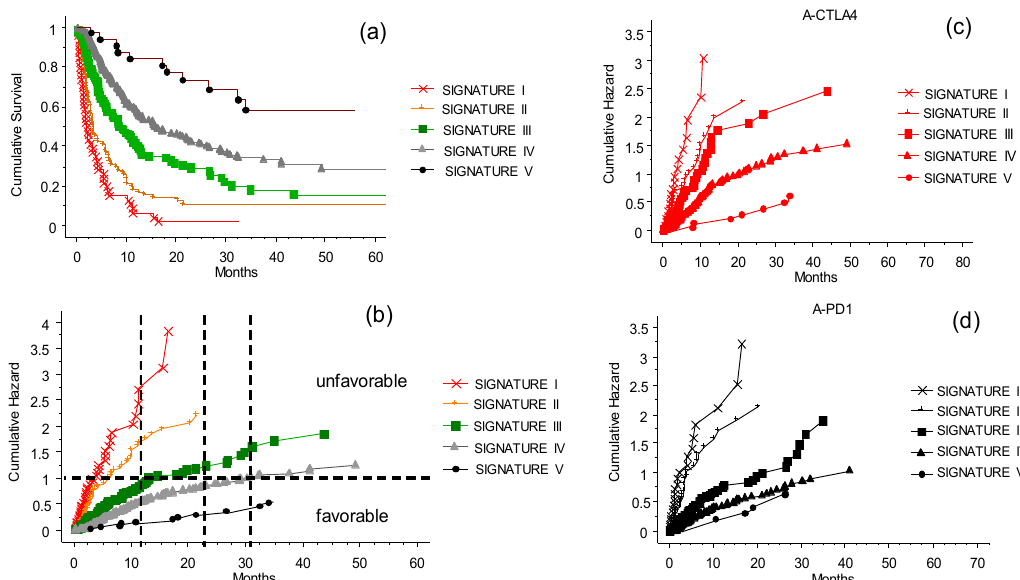
Figure 8. The CLICAL signatures and their interaction with the ICI treatments. Plot ( a ) shows the cumulative survival with the distribution of the patients grouped by their signatures. The five curves are significantly separated from one another ( p = 0.001). ( b ) Cumulative risks for each signature easily show whether the characteristics of each signature are favorable or not. Plot ( c ) presents the effect of the signature when compared with anti-CTLA-4 treatment. The difference in prediction for the five signatures is significant ( p = 0.0001). ( d ) Signatures IV and V predict a similar benefit to patients treated with anti-PD-1, and are different from Signature III as well as from I and II ( p = 0.0001).